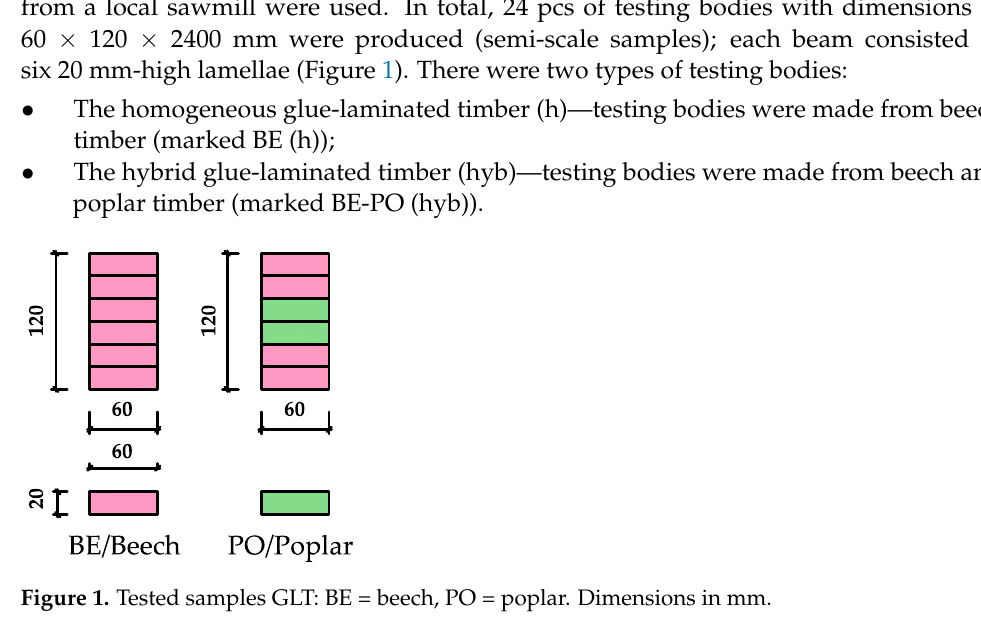
(b ) Figure 2. Production of GLT: ( a ) adhesive application and ( b ) beam arrangement in the press (au- thors’ archive). The density of the timber was determined from single non-glued lamellae according to standard Č SN 49 0108 [37]. Density determination tests were performed on the set of specimens intended for the lamellae bending tests described below. The tests were per- formed with the remaining lamellae that had not been used for the production of GLT